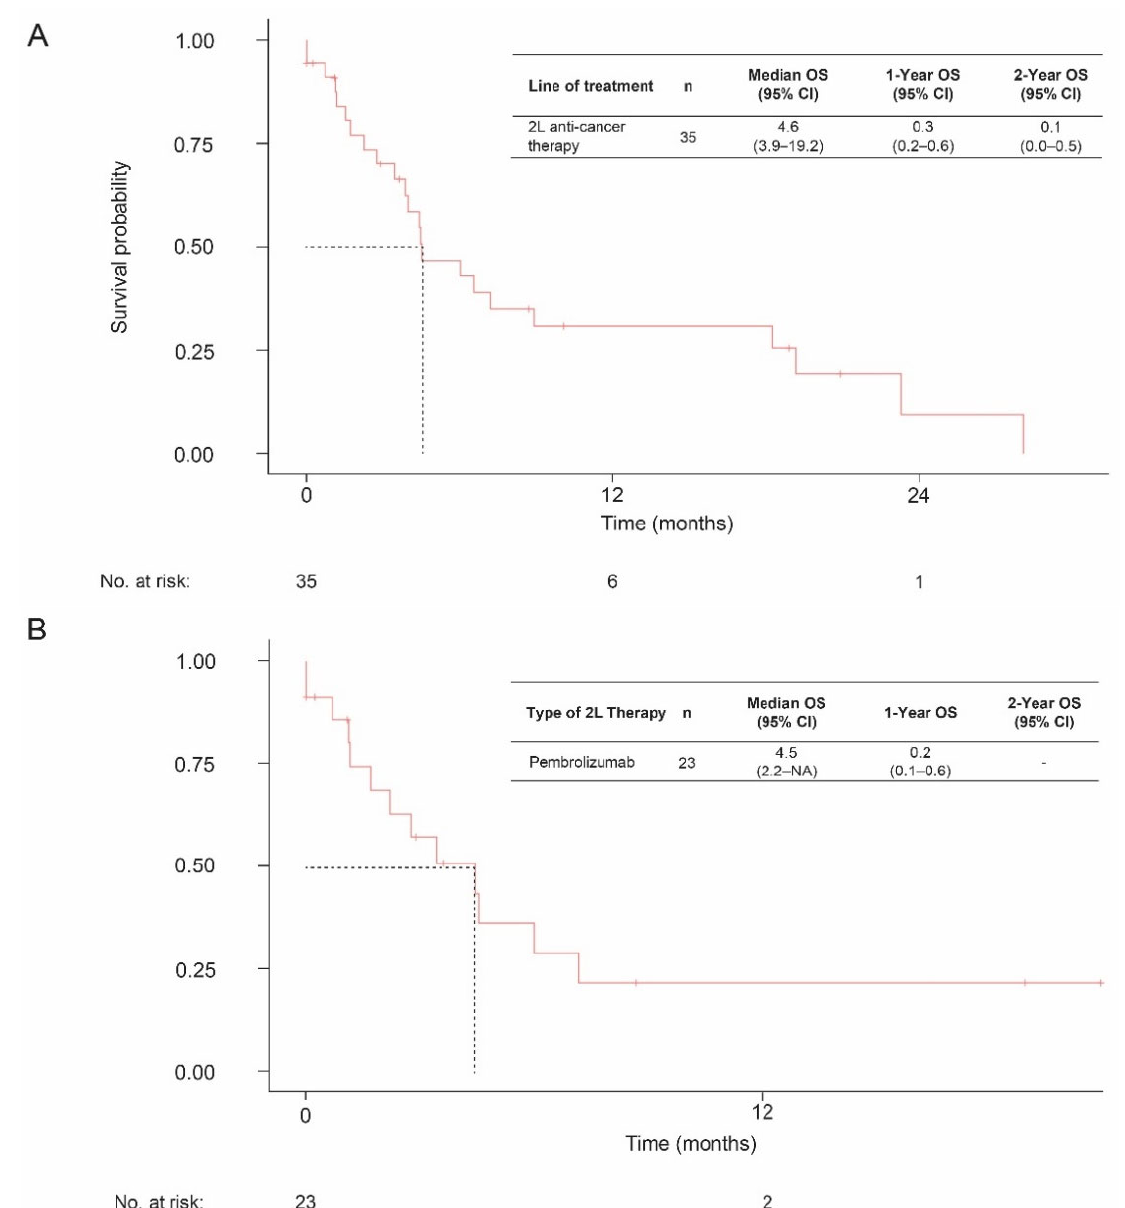
Figure 2. OS from start of second-line therapy among patients with de novo la/mUC following initiation of second-line systemic therapy, ( A ) overall, and ( B ) by therapy received. Abbreviations: 2L, second line; CI, confidence interval; la/mUC, locally advanced or metastatic urothelial carcinoma; NA, not available; OS, overall survival.